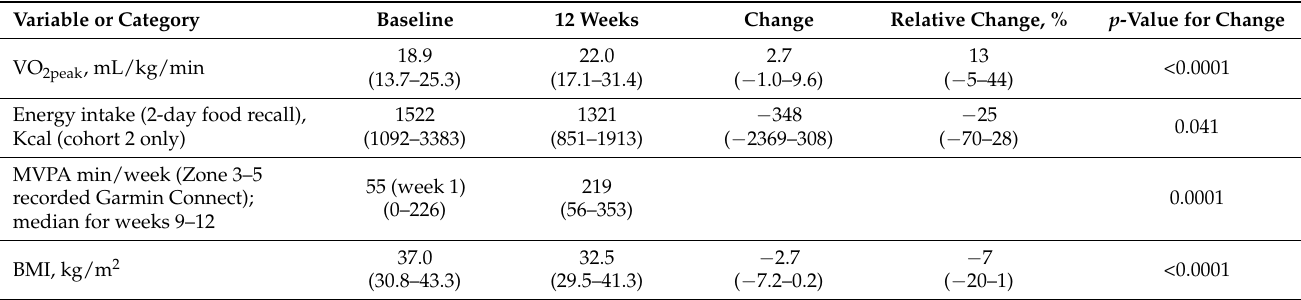
Table 2. Changes in physical activity, energy intake and morphometric (iDXA) parameters for 22 women completing the 12-week weight-loss intervention which included twice weekly personal trainer sessions. Median (range) values. p -values from Wilcoxon signed rank test,